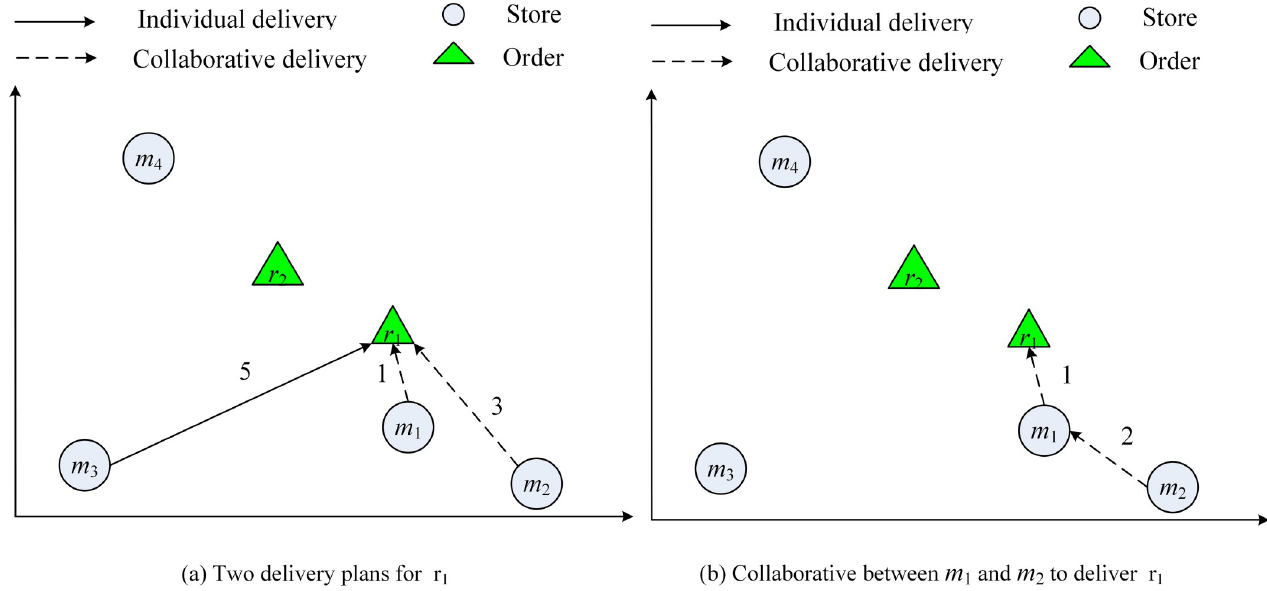
Fig 2. The example of individual and collaborative delivery of r 1 . The dotted line represents multi-store collaborative delivery, and the solid line shows single-store delivery.